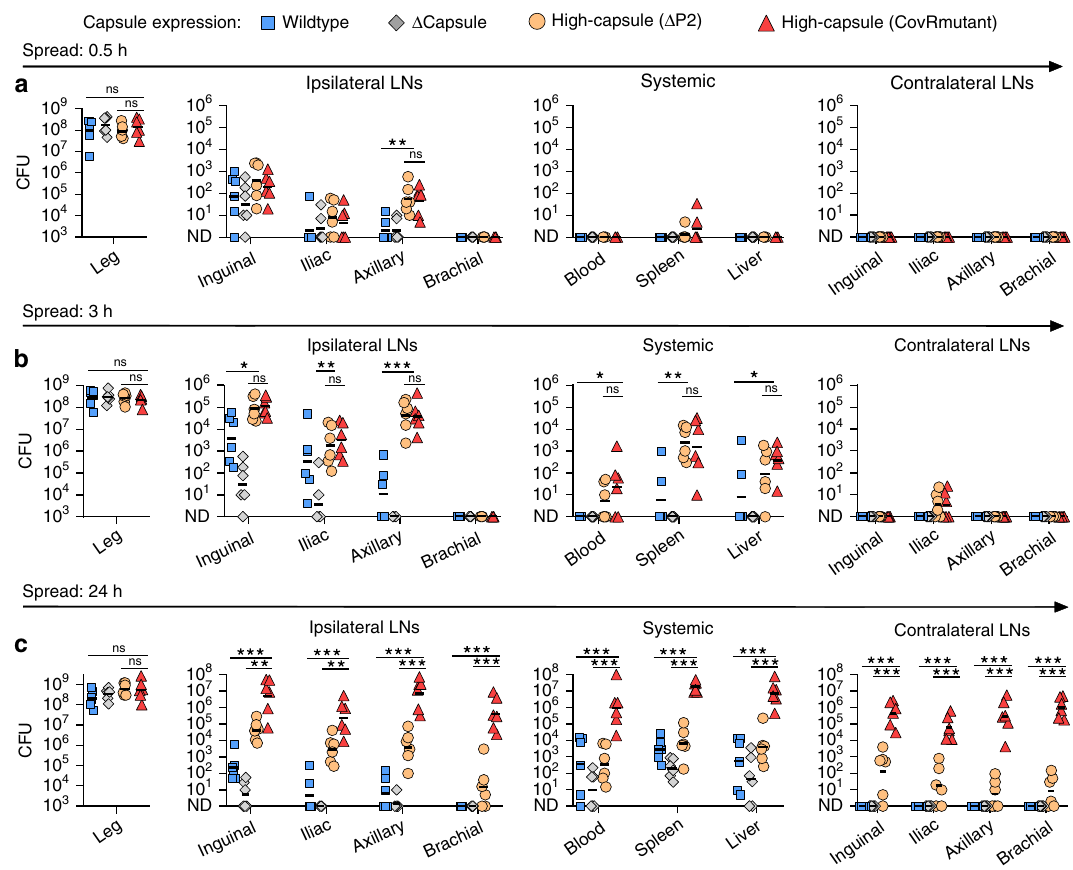
Fig. 4 Bacterial virulence factors determine the extent and consequences of lymphatic-dissemination. a – c Recovery of a panel of isogenic S. pyogenes isolates from the hindlimb infection site, lymph nodes, and systemic organs of FVB/n mice at 0.5 h ( a ), 3 h ( b ), or 24 h ( c ) after intramuscular infection with 10 8 CFU. Isogenic strains were: wildtype (H584); acapsular mutant, Δ capsule (H1454); high-capsule Δ P2 (H1458); and high-capsule CovR mutant (H1565). Symbols represent individual mice, n = 6 per group, black lines indicate geometric means. * p ≤ 0.05; ** p ≤ 0.005; *** p ≤ 0.001; ns, p > 0.5: one- way ANOVA followed by Tukey ’ s multiple comparisons post-tests were performed on log10-transformed data. CFU are per ml of blood, per g of liver, per leg, or per